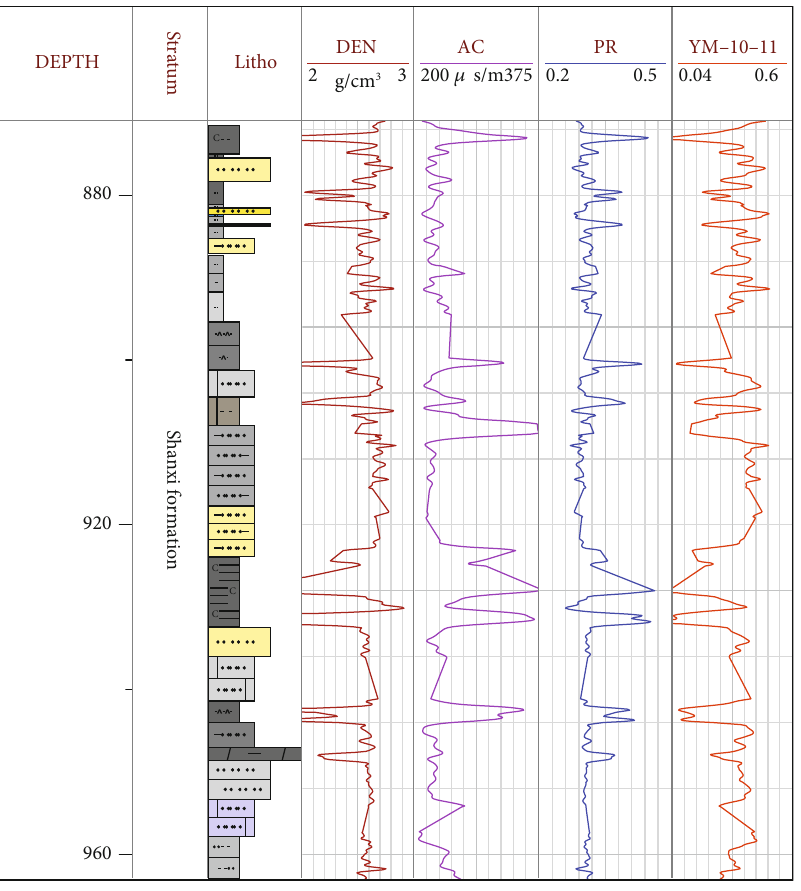
Figure 9: Calculation results of rock mechanics parameters of Well